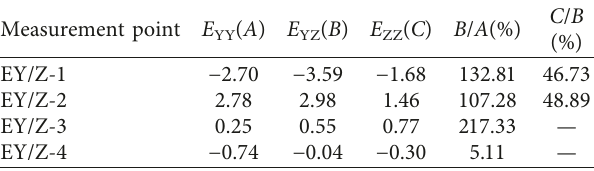
Figure 16: Displacement at monitoring points of secondary lining: (a) right tunnel; (b) left tunnel. Table 4: Displacements of the secondary lining (mm).